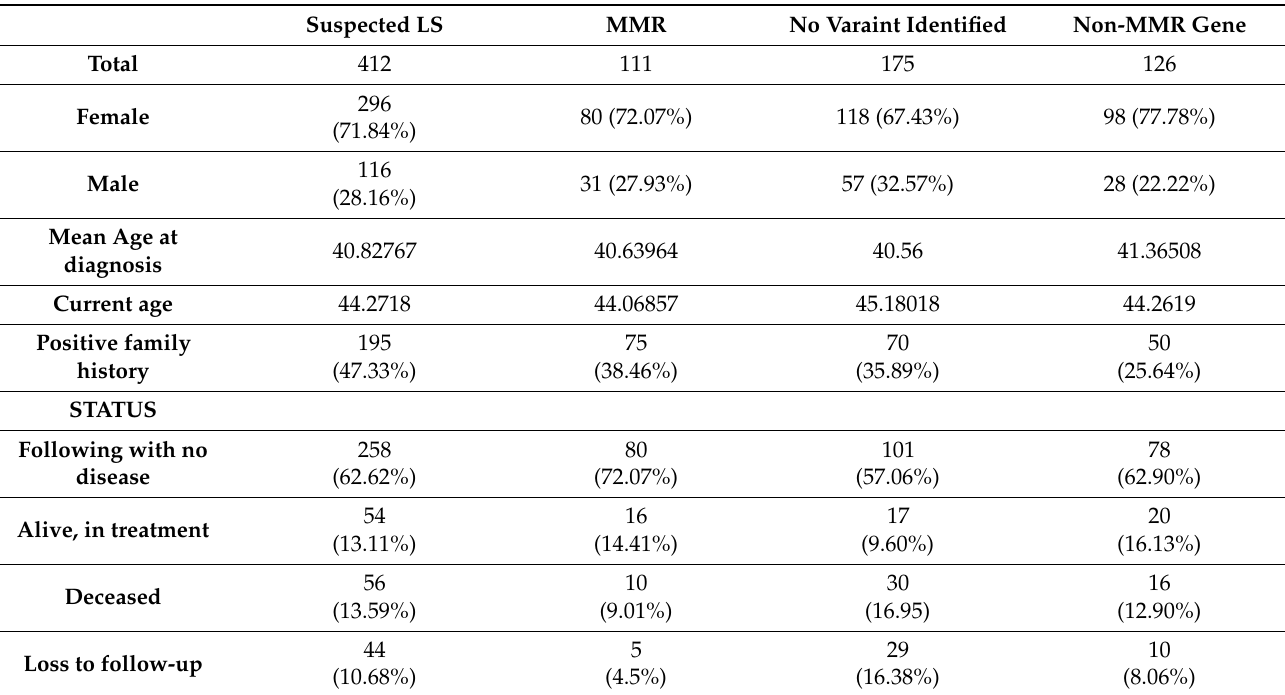
Table 1. Socio-demographic characteristics of the cohort with suspected Lynch